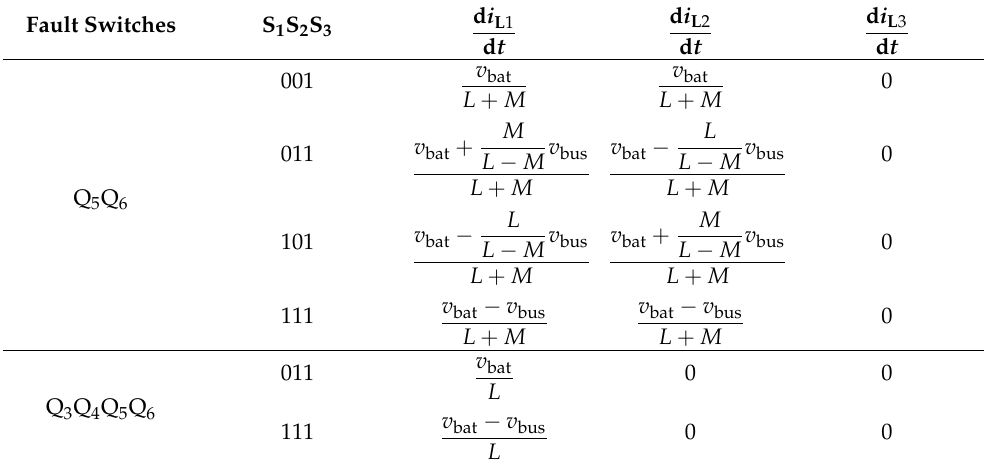
Table 2. Current changing rate after OCF is cut